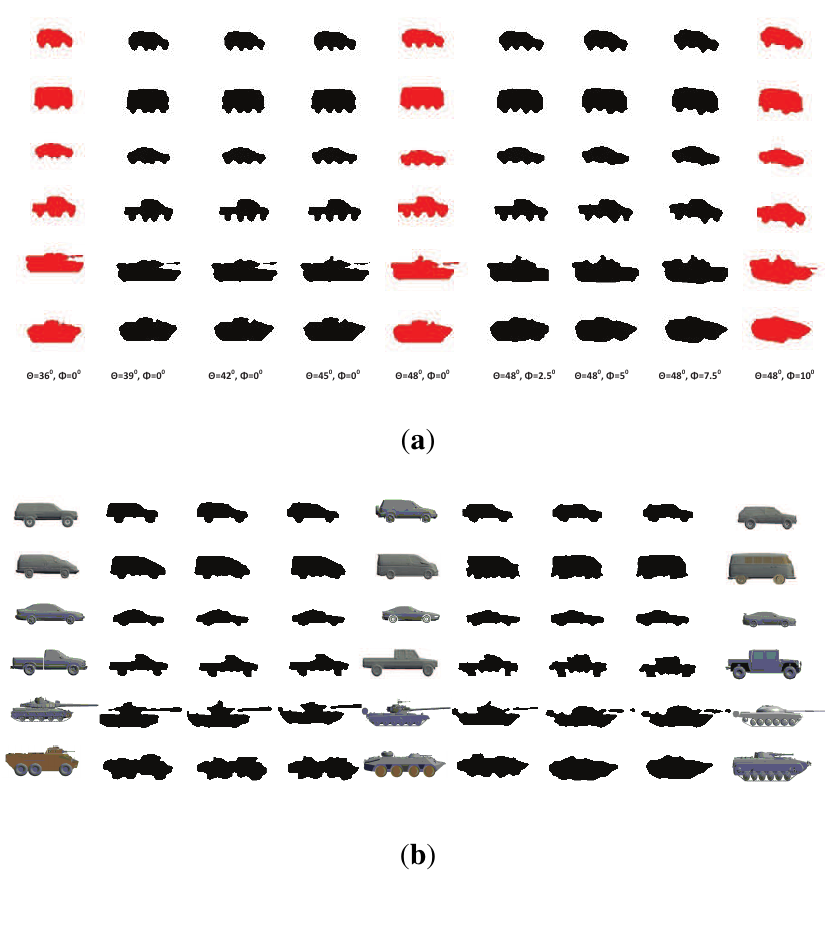
Figure 9. Qualitative analysis of JVIM shape interpolation: ( a ) along six identity-specific view manifolds. ( b ) along the view-independent identity manifold between two training target types. (Reprint from [24], with permission from